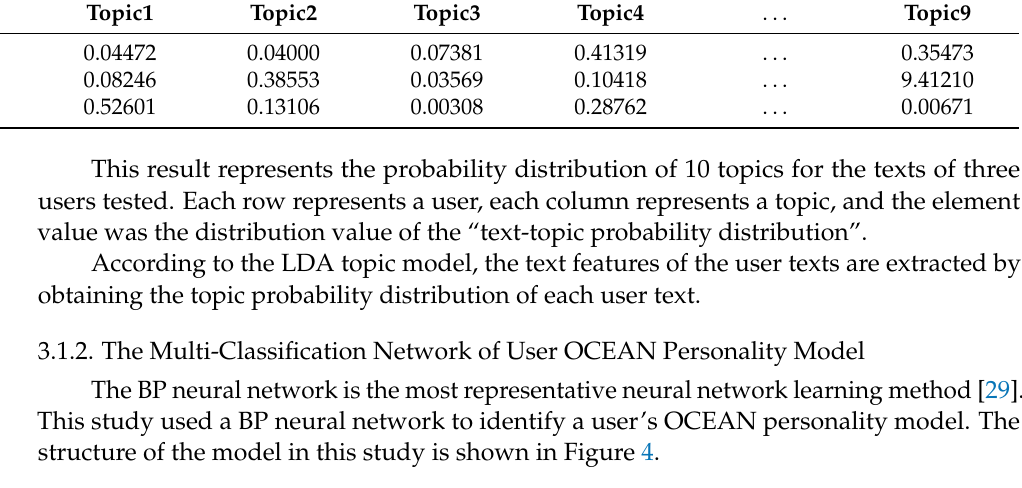
Table 5. Text-topic probability distribution